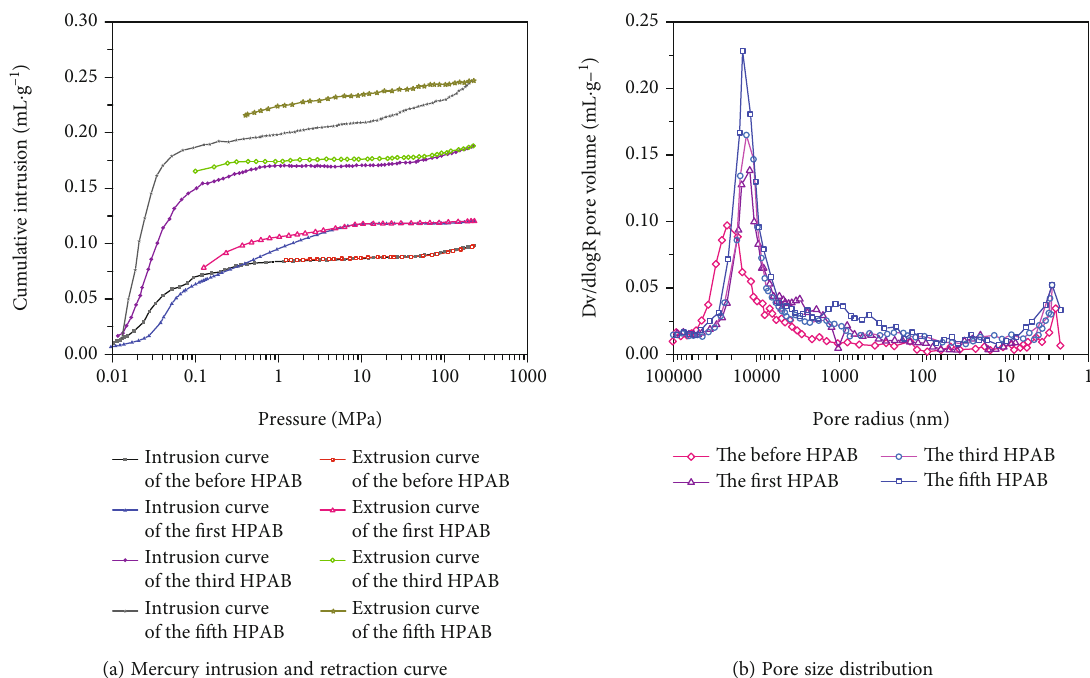
Figure 9: Mercury intrusion and retraction curve and pore size distribution of the specimen under multiple HPAB